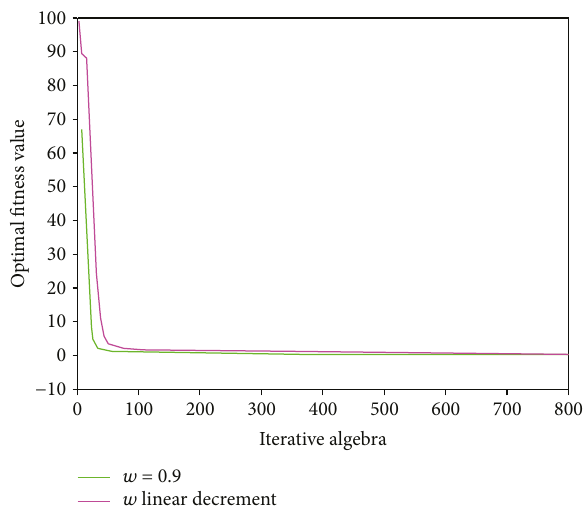
Figure 13: Comparison between GA and PSO.